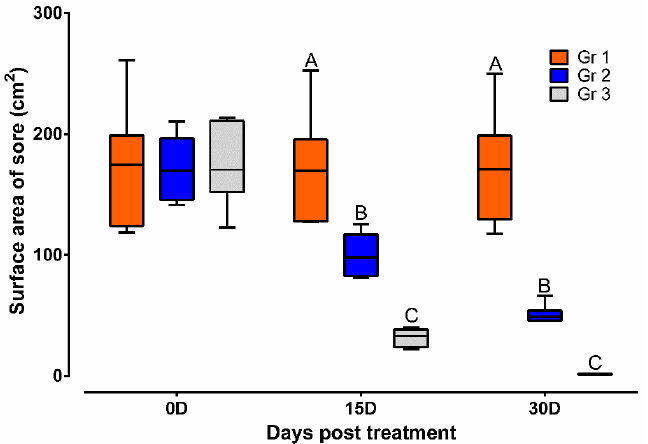
Figure 2. Sore surface area in different treatment groups. Data are shown as box plots. A,B,C Value with different superscript in a particular time point indicate significant difference among groups. Gr 1: infected animals without treatment, Gr 2: treatment group with ivermectin alone, Gr 3: treatment group with tri-model therapy.